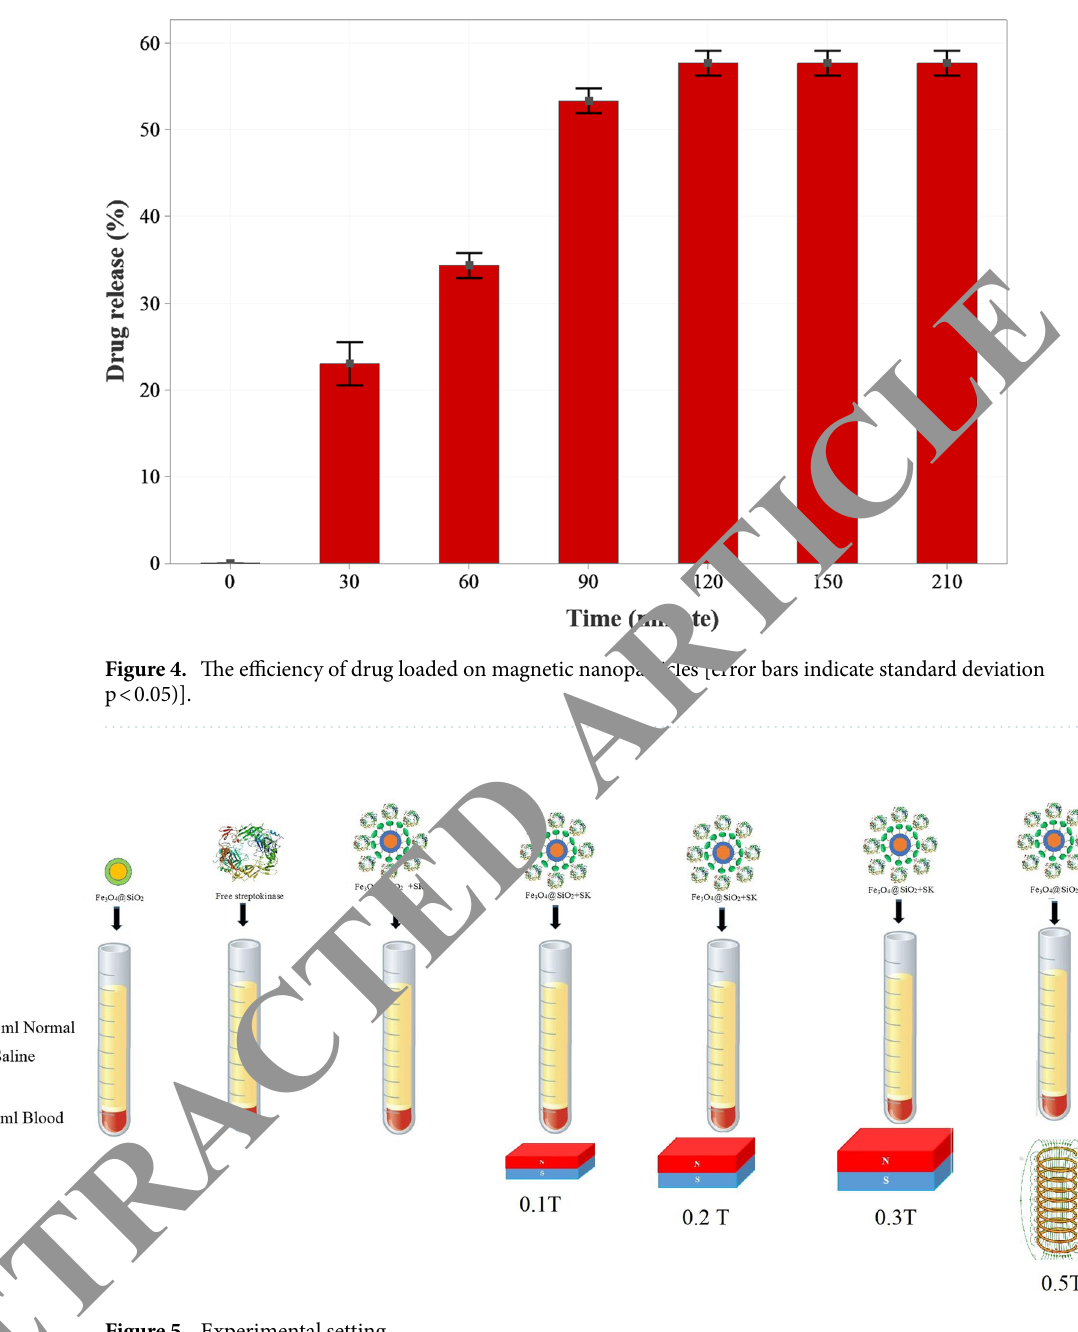
Figure 5. Experimental